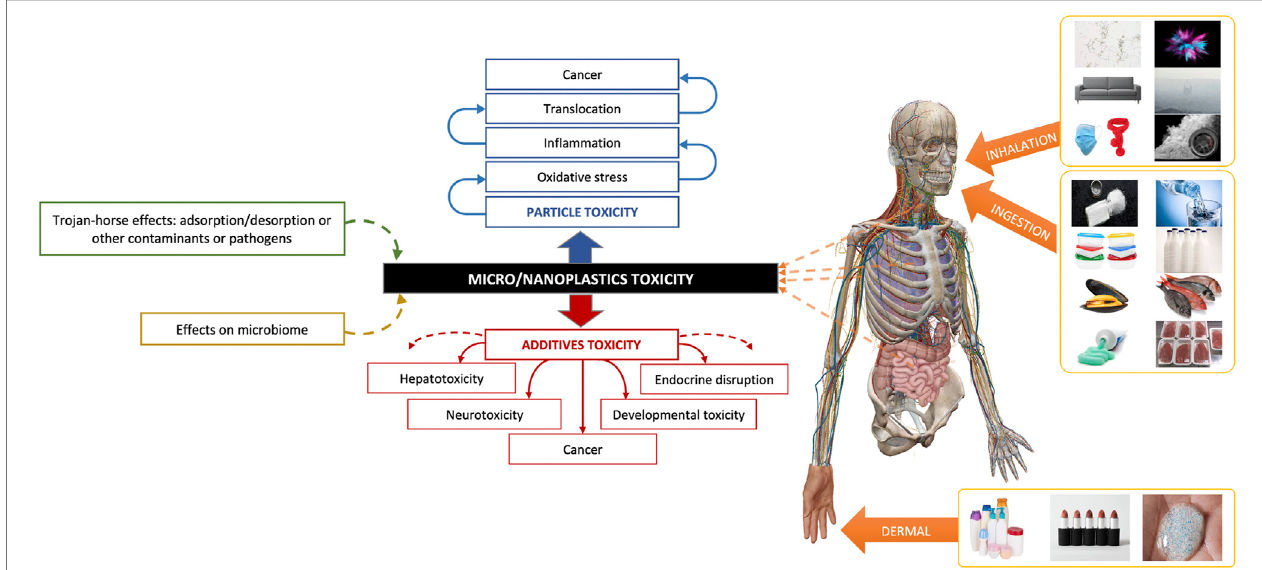
FIGURE 1 | Summary of the human routes of exposure to MNPLs and their potential effects on health.